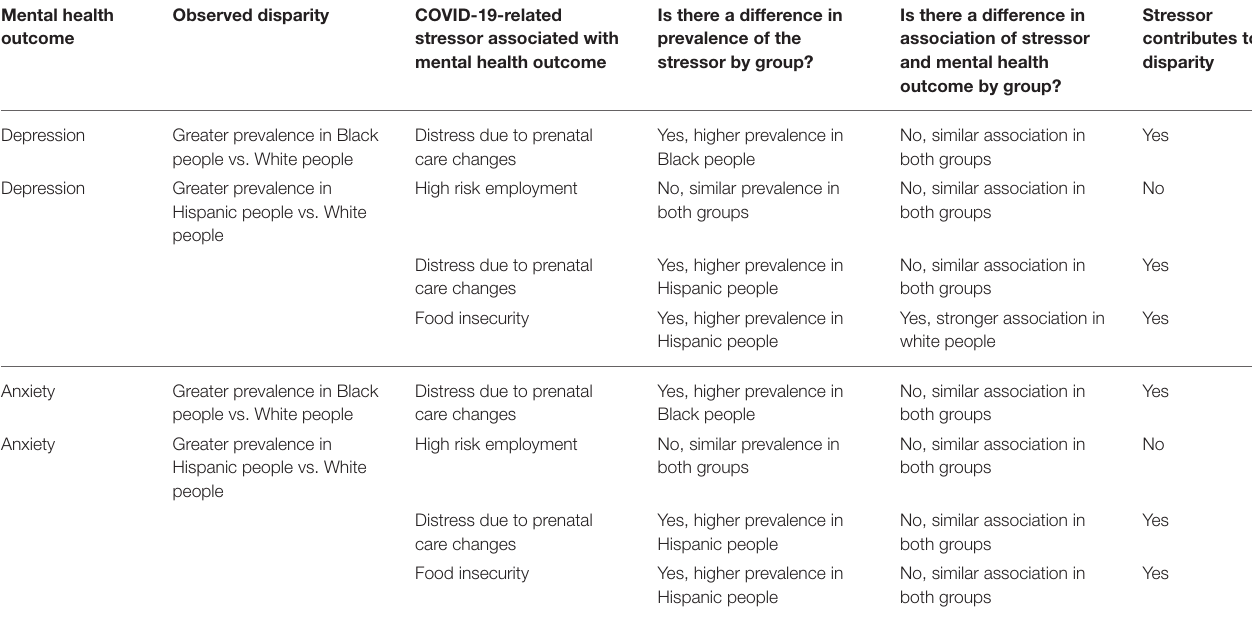
Stressor contributes to disparity